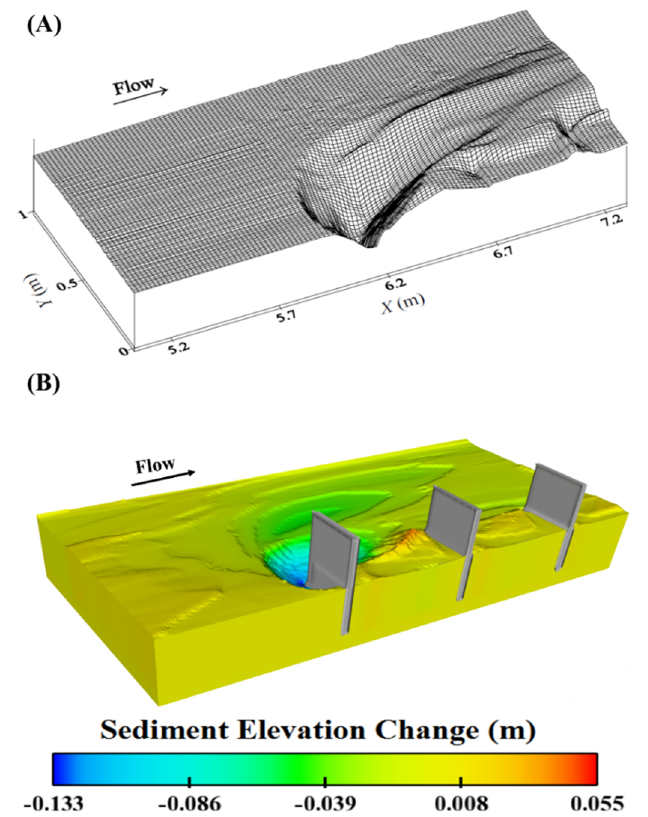
Figure 5. Bed elevation changes from ( A ) laboratory experiments and ( B ) FLOW-3D.